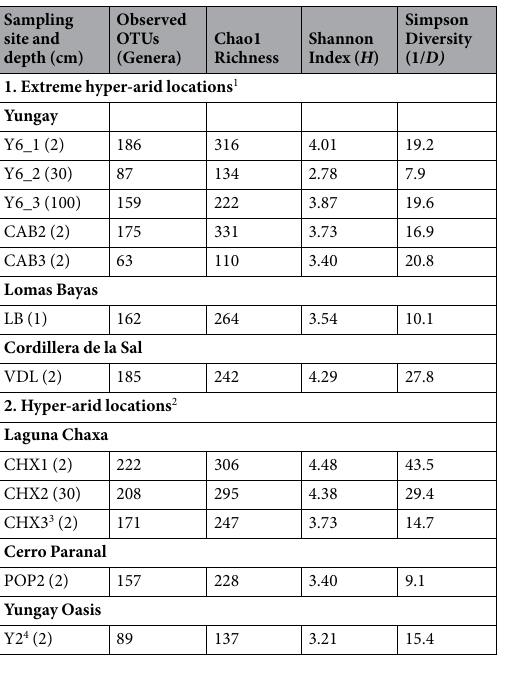
Table 1. Observed OTUs and α -diversity indices. 1 MAR 0.002, 2 MAR 0.009, 3 Partly colonized by cyanobacteria, 4 Tamarisk grove.